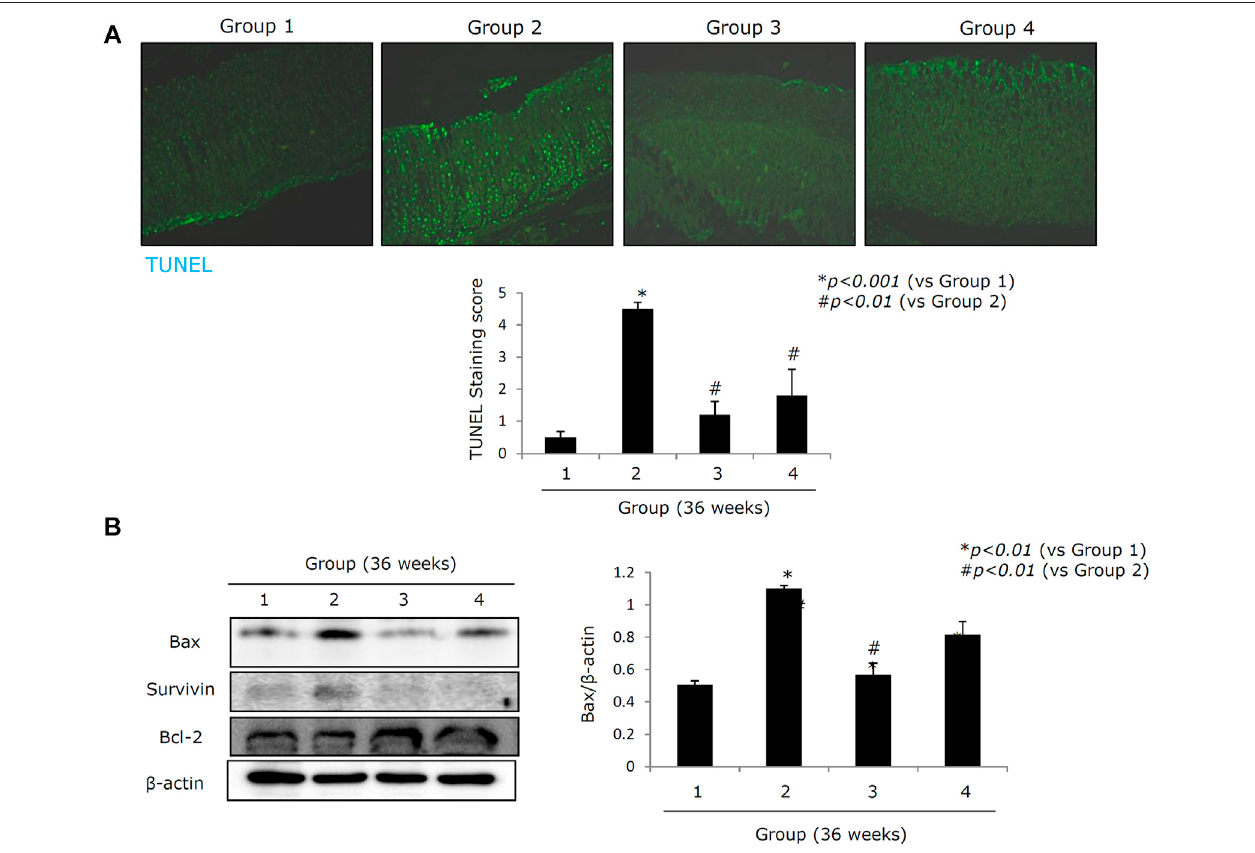
FIGURE3| Apoptoticstatusaccordingtogroups. (A) TUNELstainingwithapoptoticindexaccordingtogroups,x100magni fi cation. (B) Westernblotforapoptotic executors, Bax, surviving, and Bcl-2. (C) Changes of RGM-1 cells ’ viability after H. pylori infection in a different time point and different POI in a transwell co-culture system. Cell counting using a hemocytometer and trypan blue for measuring cell viability was done after 24 hr of H. pylori infection in the absence or presence of PD- MSCs. (D) Westernblotforapoptotic executors inthepresenceorabsenceofPD-MSCsunder H.pylori infection, 100MOI, 24 hr. (E) Western blotforautophagy, Beclin1, cleaved Beclin1, ATG5, and LC3B in the presence or absence of PD-MSCs under H. pylori infection, 100 MOI, 24 hr. (F) Confocal imaging of LC3B after CM administration. (G) Cell viability after PD-MSCs in the presence of H. pylori infection in mock cells and LC3B siRNA transfection. All data represent mean ± SD ( n (cid:1) 10).